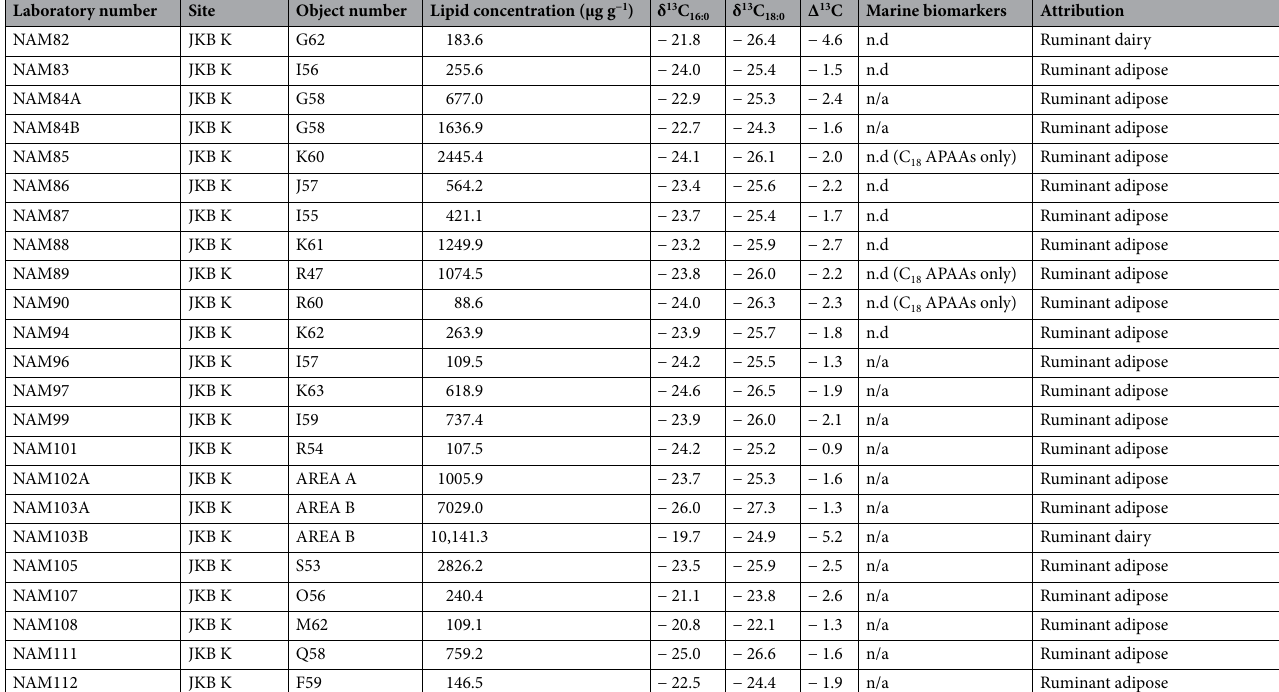
Table 3. Lab/sample number, site, object number, lipid concentration (μg g −1 ), δ 13 C and Δ 13 C values, marine biomarkers present (n/a = not analysed and n/d = not determined) and attribution of